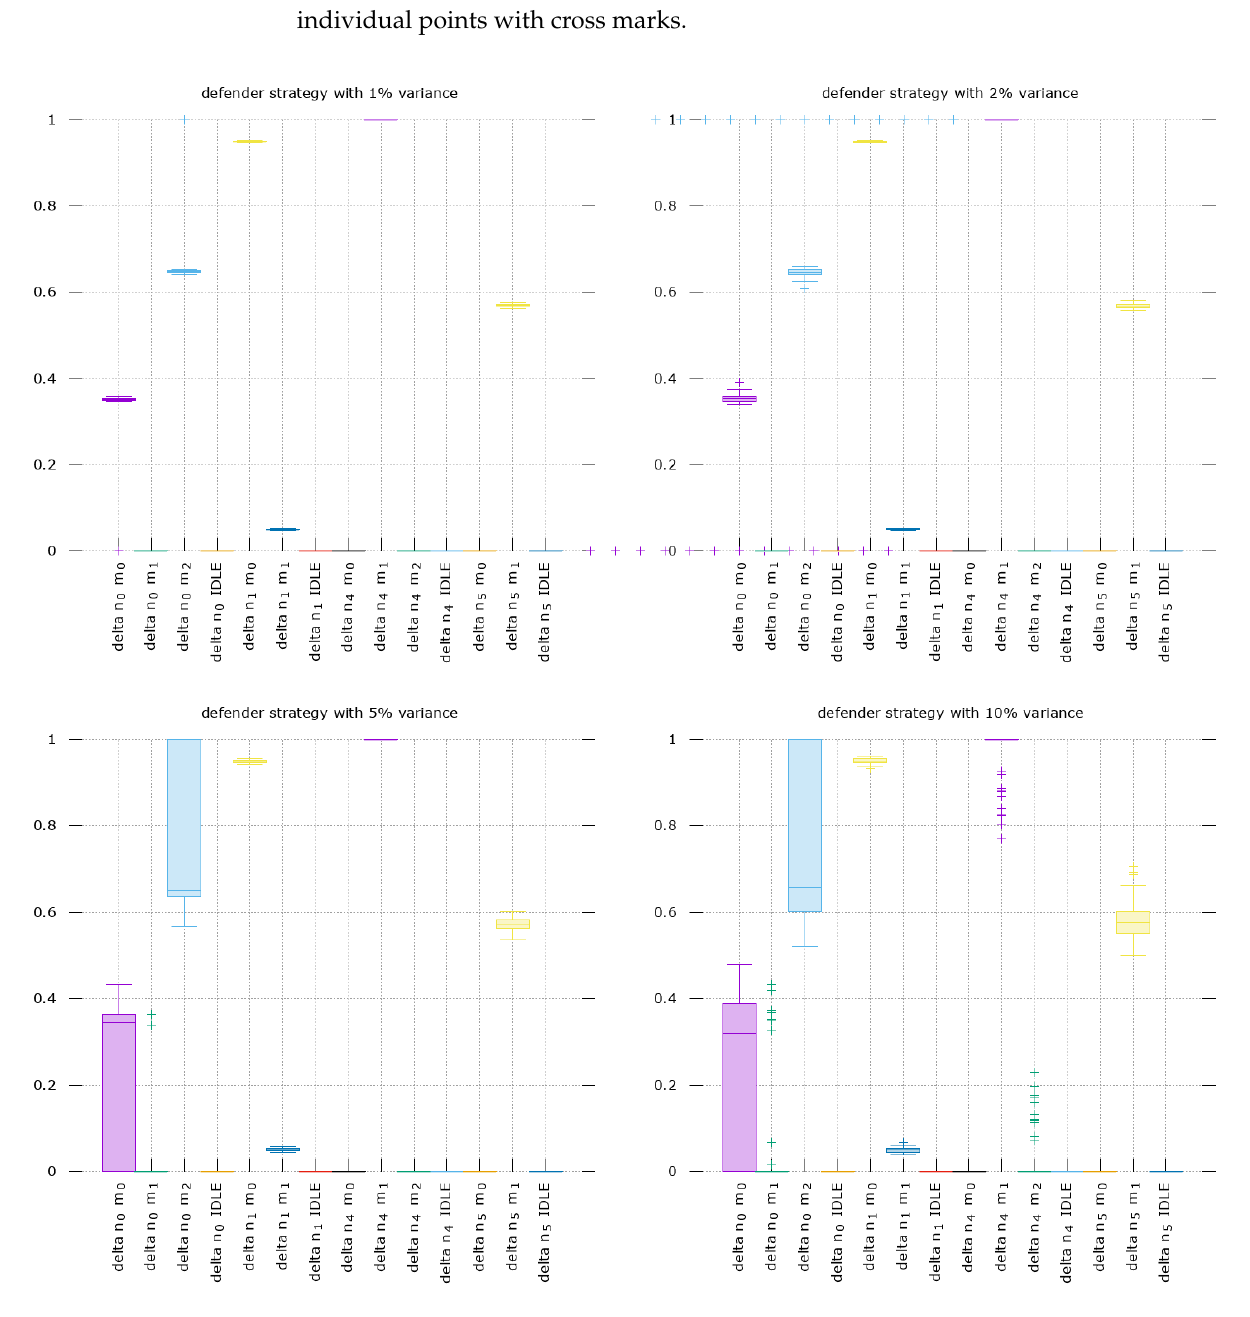
Figure 7. How stable the strategies are considering variance in the